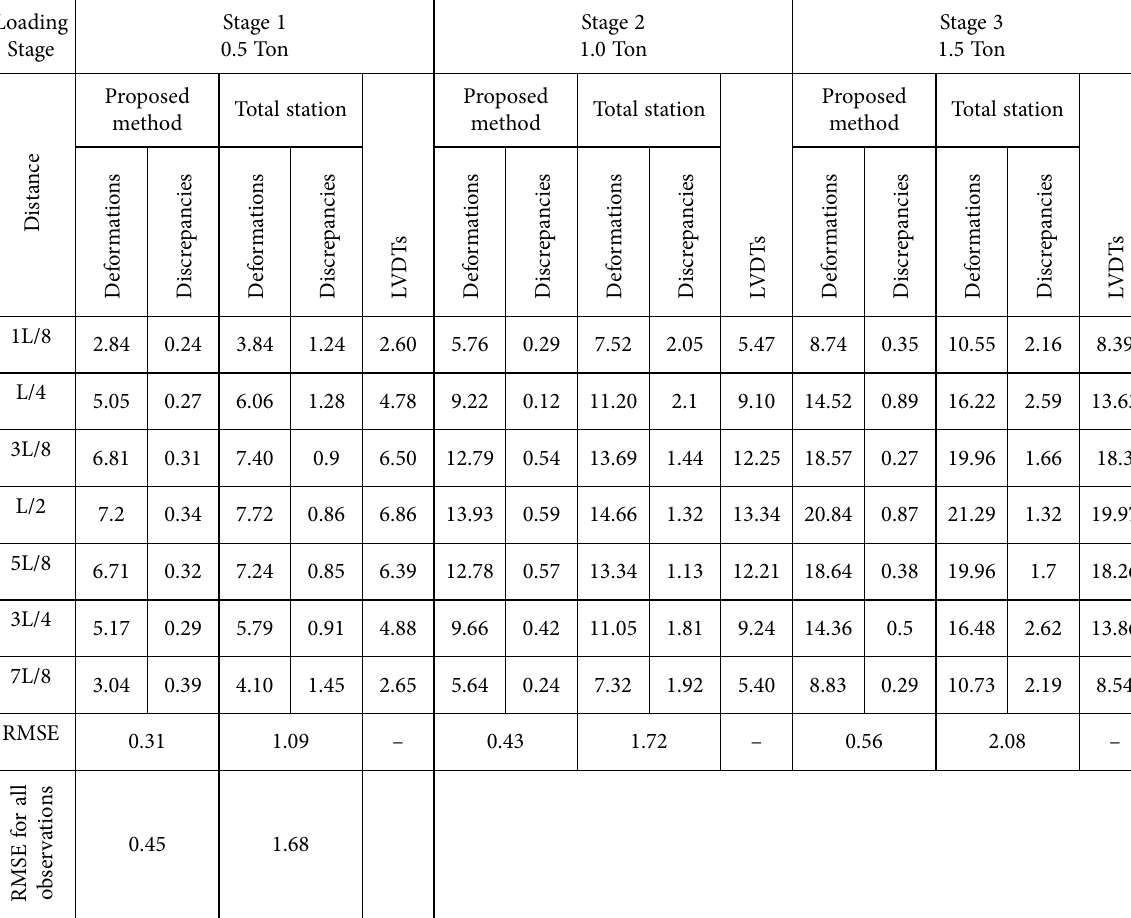
Table 1. Values of vertical deflections and discrepancies (in